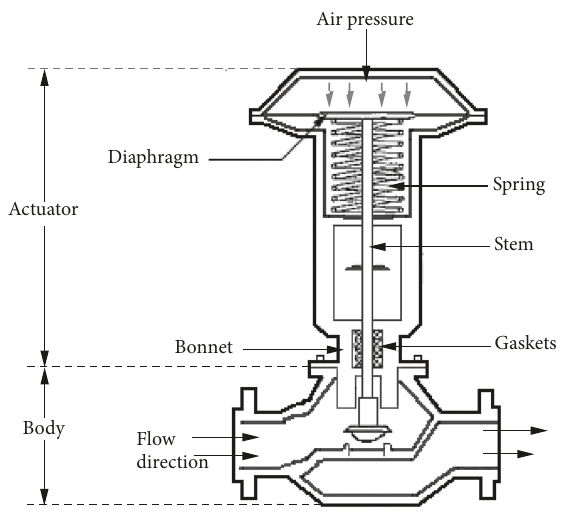
Figure 1: Body and actuator of a control valve with pneumatic actuator (adapted from [11]).